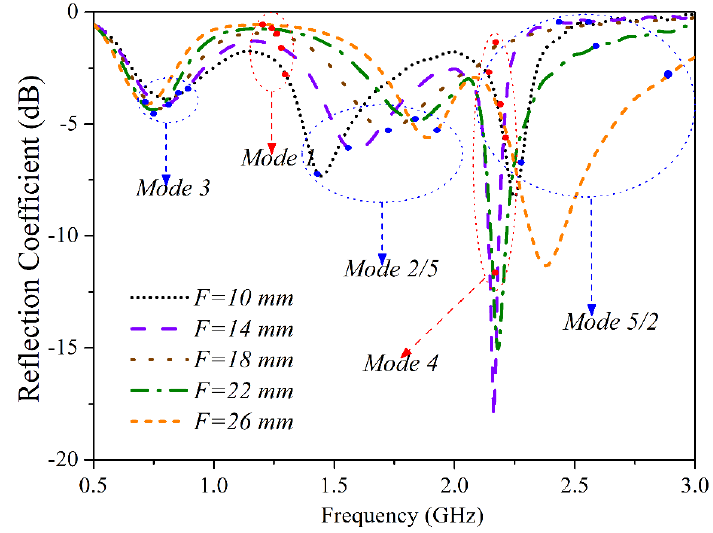
Figure 5. |S 11 | with different values of F : 10 mm, 14 mm, 18 mm, 22 mm, and 26 mm. Electronics 2018 , 7 , x FOR PEER REVIEW